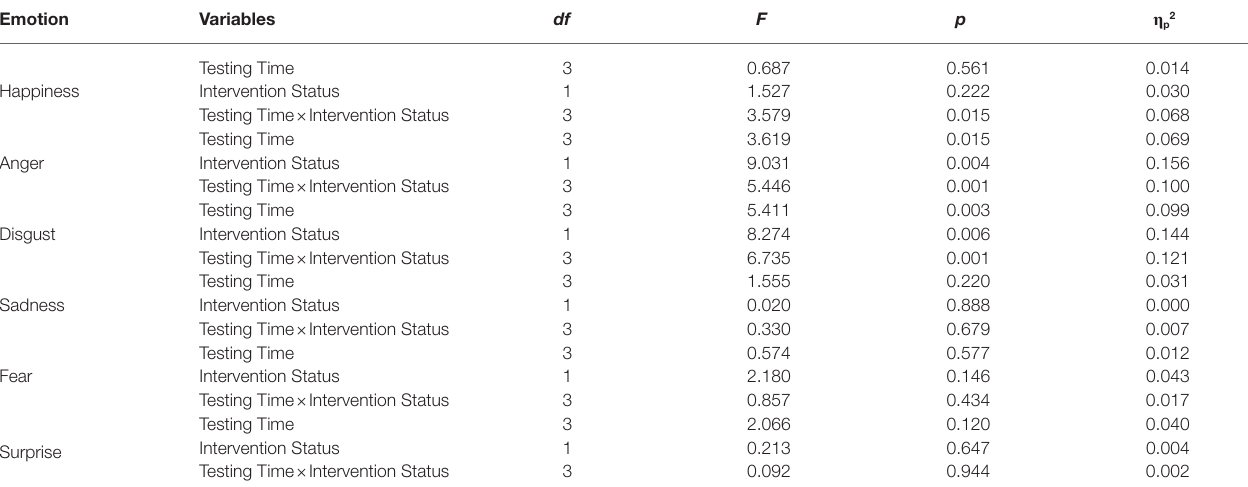
TABLE 2 | The Analysis of Variance Statistics for the Emotion Recognition Test.